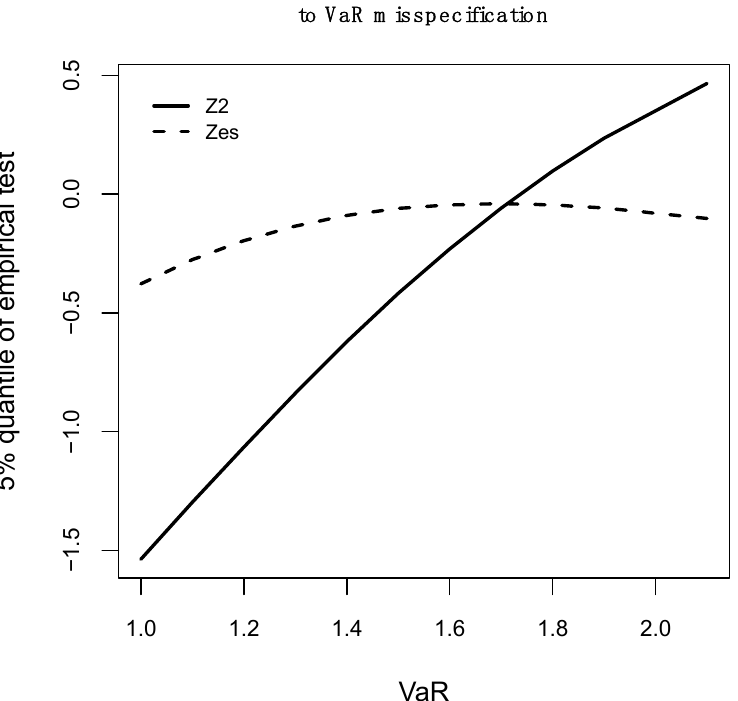
Figure 1. Sensitivity of the test Z 2 and Z ES to VaR .